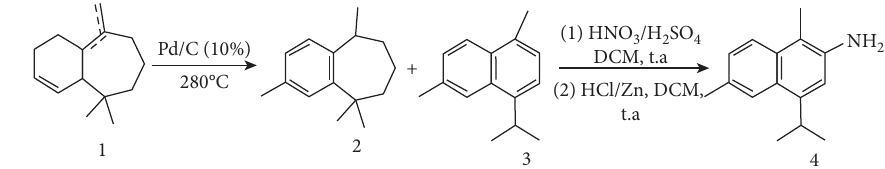
Figure 1: Scheme for synthesis of ACM.